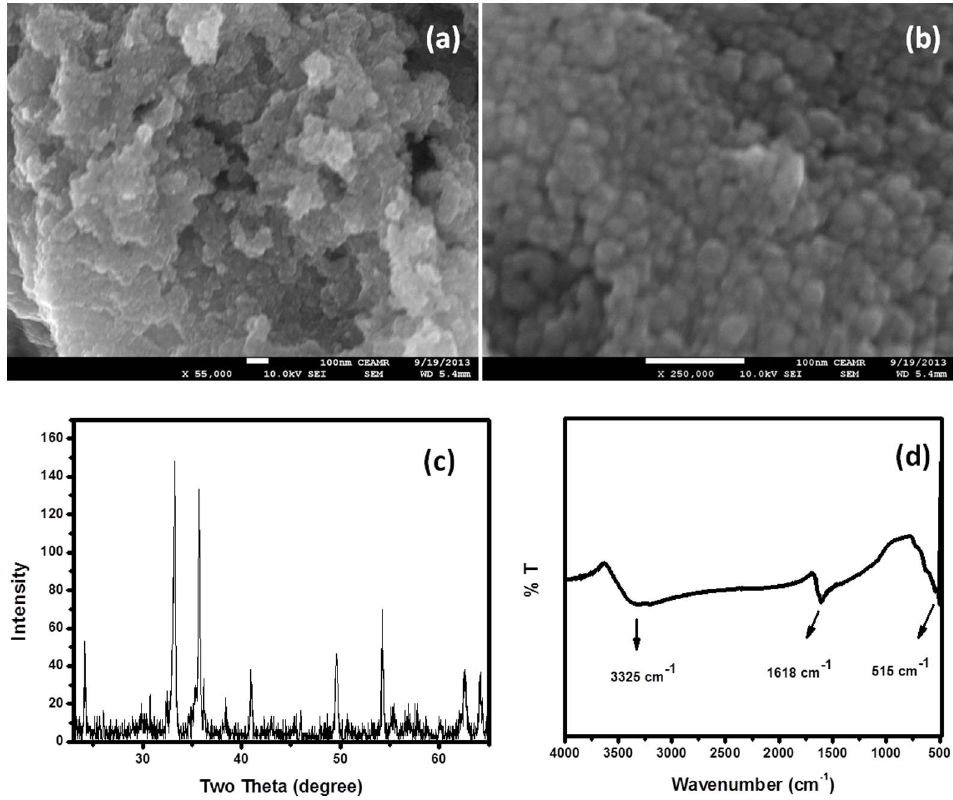
Figure 4. UV spectrum of composite nanoparticles.